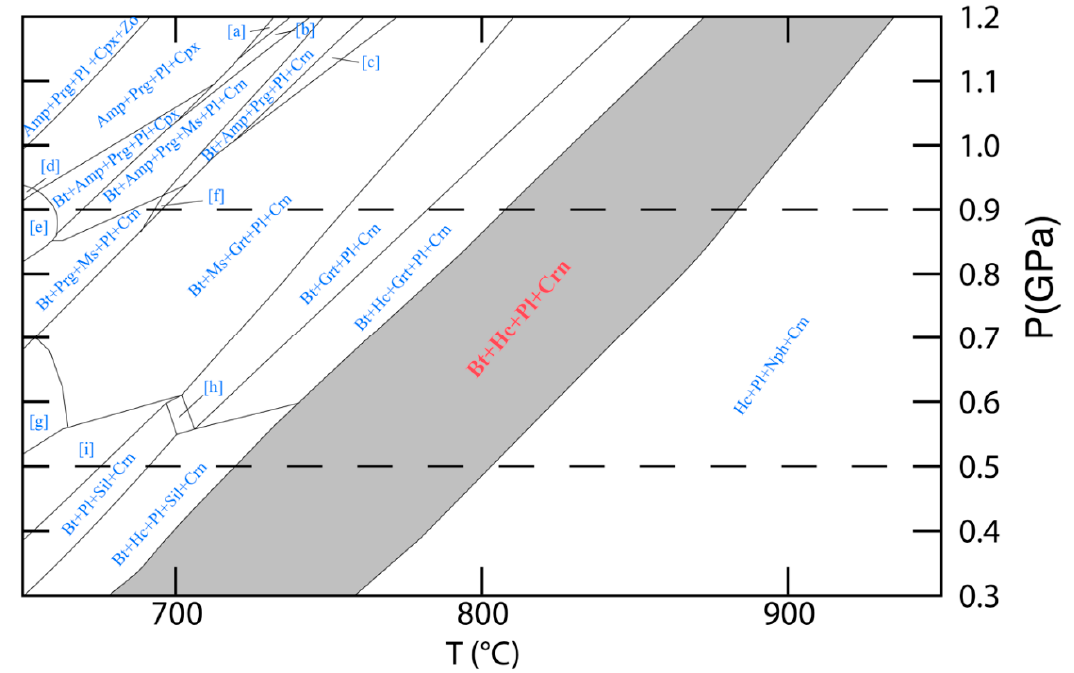
Figure 11. P-T pseudosection calculated for the chemical composition provided by Bertolani [13] for the plumasitic dyke recognized in Val Sabbiola, along the road to Montata village, which location and mineral assemblage correspond to our anorthosite SB08. The grey field corresponds to the mineral assemblage of SB08 rock. The dashed line indicates the pressure conditions estimated for the emplacement of the Mafic Complex during Carboniferous–Permian interval [72]. In the small stability field we reported the letters to indicate the mineral assemblage in those fields: [a]: Amp + Prg + Pl + Cpx + Crn;